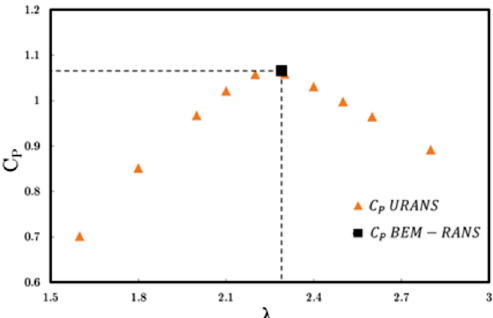
Fig. 9. Power coef fi cient of an isolated HPS in a channel ( ’ = 0.29 and V 0 = 2.25 m/s). Numerical prediction by the URANS model from a set of computations performed for various l compared to the power coef fi cient of a single steady BEM-RANS